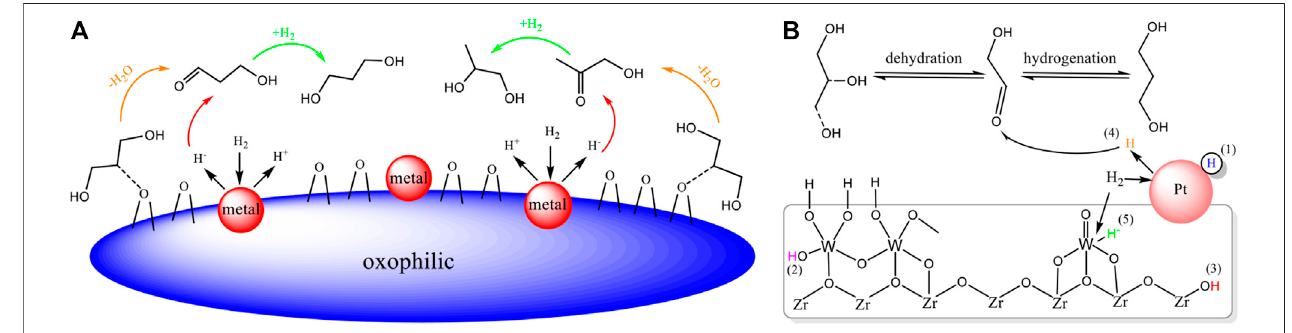
FIGURE 2 | (A) Dehydration-hydrogenation mechanism of glycerol hydrogenolysis; (B) different types of hydrogen species on the surface of the Pt/WO x /ZrO 2 catalyst.